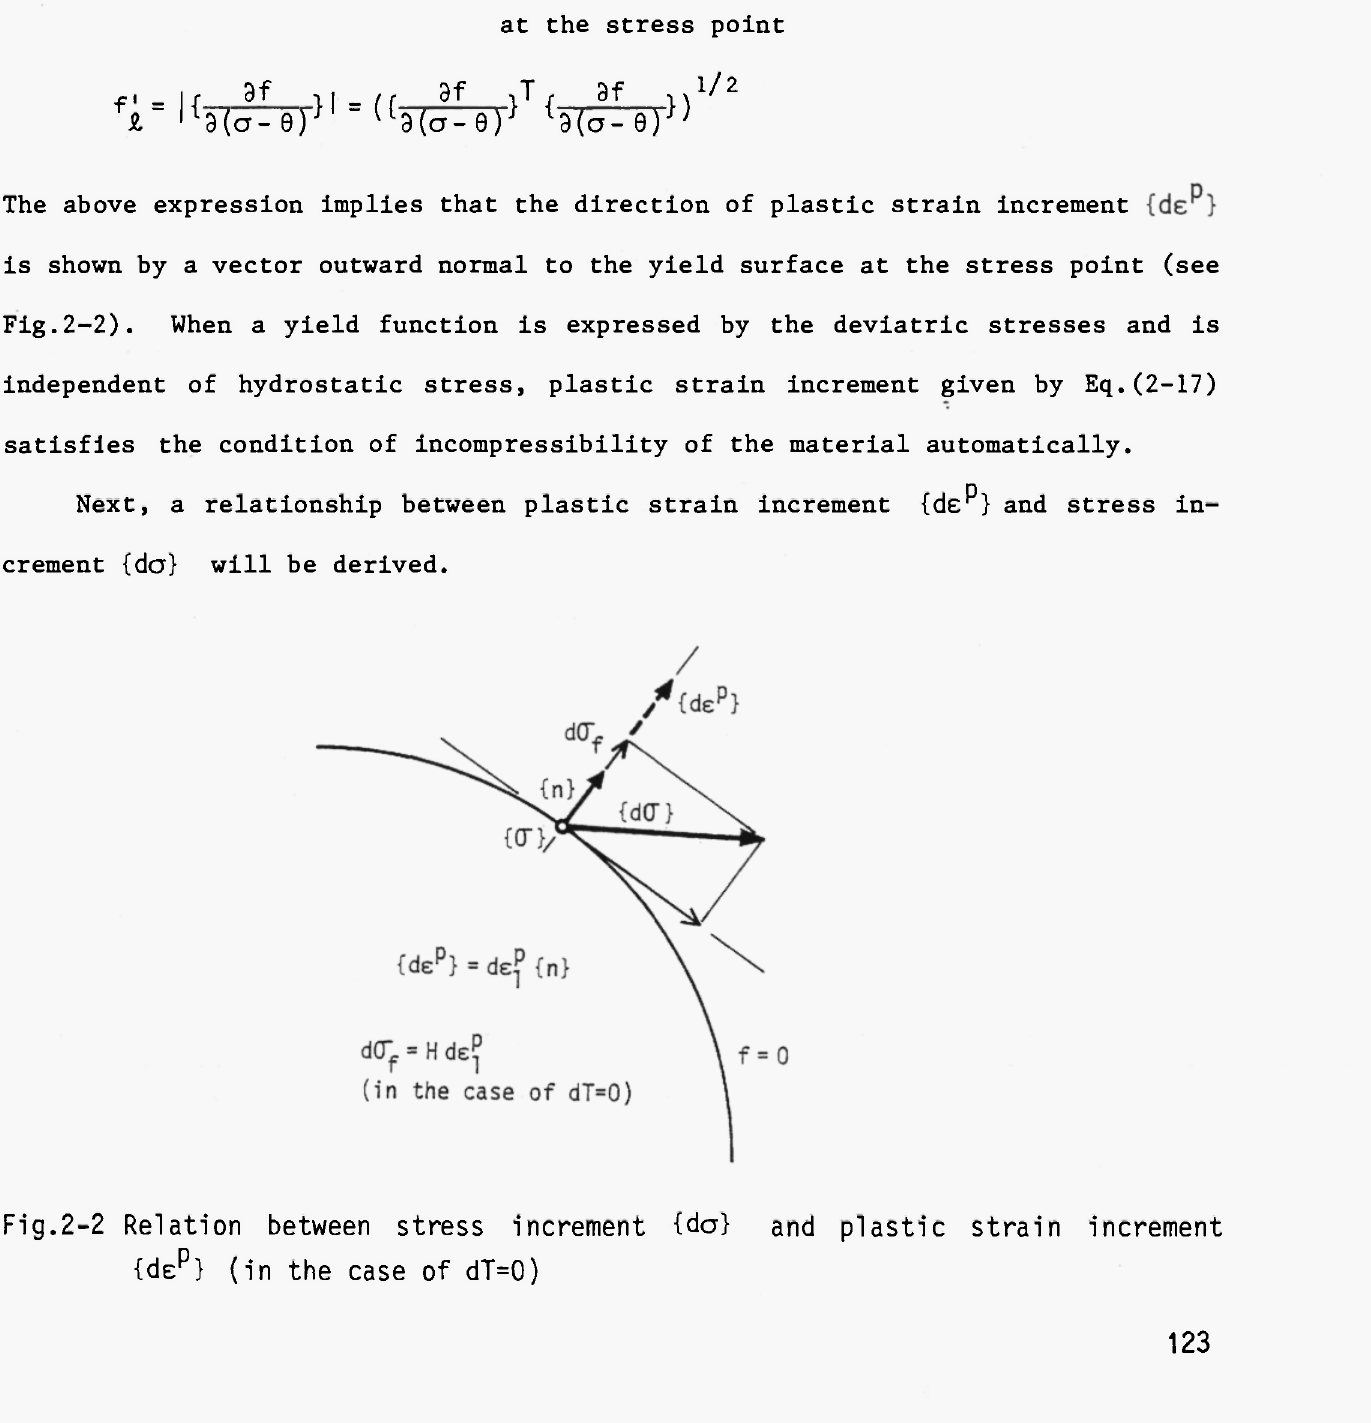
Fig.2-2 Relation between stress increment {da} and plastic